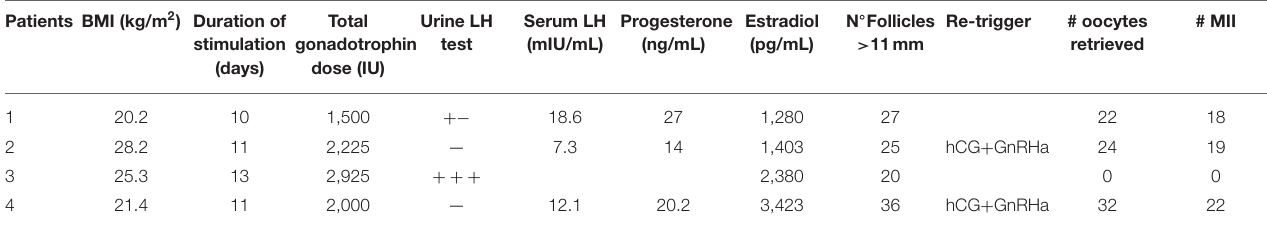
TABLE 2 | General characteristics of the patients with abnormal results in the urine LH test or failed oocyte retrieval after a positive LH test in urine. Patients BMI (kg/m 2 ) Duration of